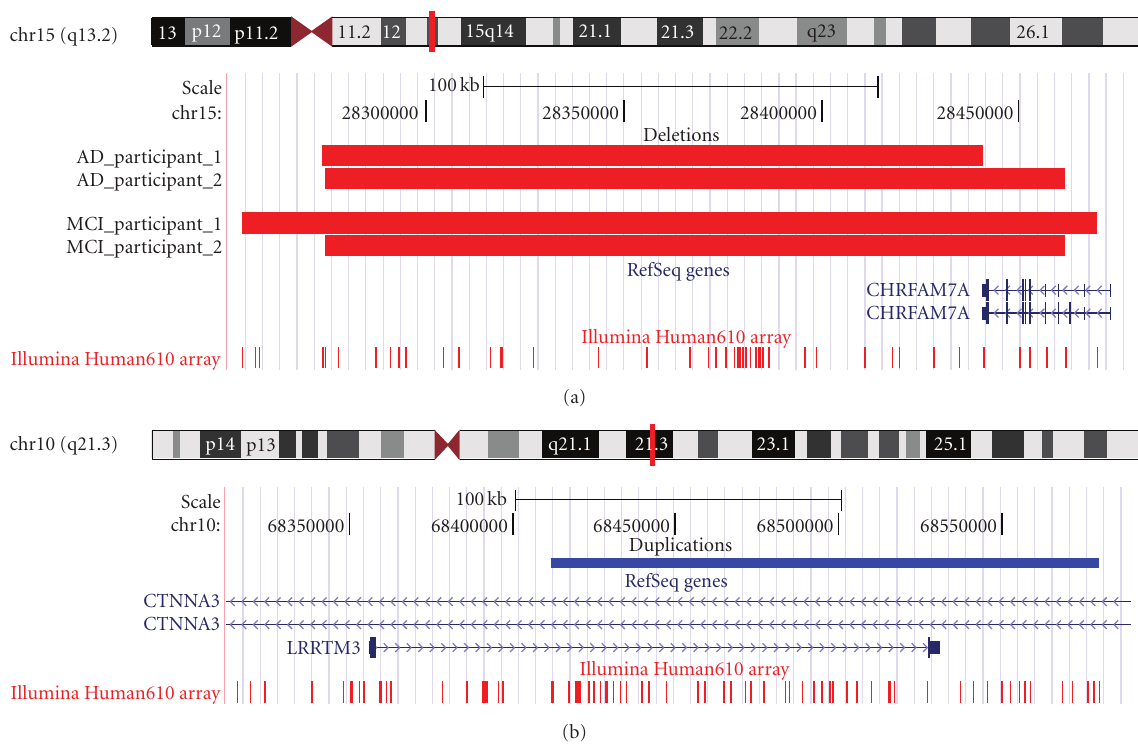
Figure 1: Examples of candidate genes (a) CHRFAM7A and (b) LRRTM3 , overlapped by CNV calls from at least one Alzheimer’s disease and/or one mild cognitive impairment participant, but no healthy controls. The red rectangles represent deletions, and the blue rectangles represent duplications (March 2006 (NCBI36/hg18) assembly).